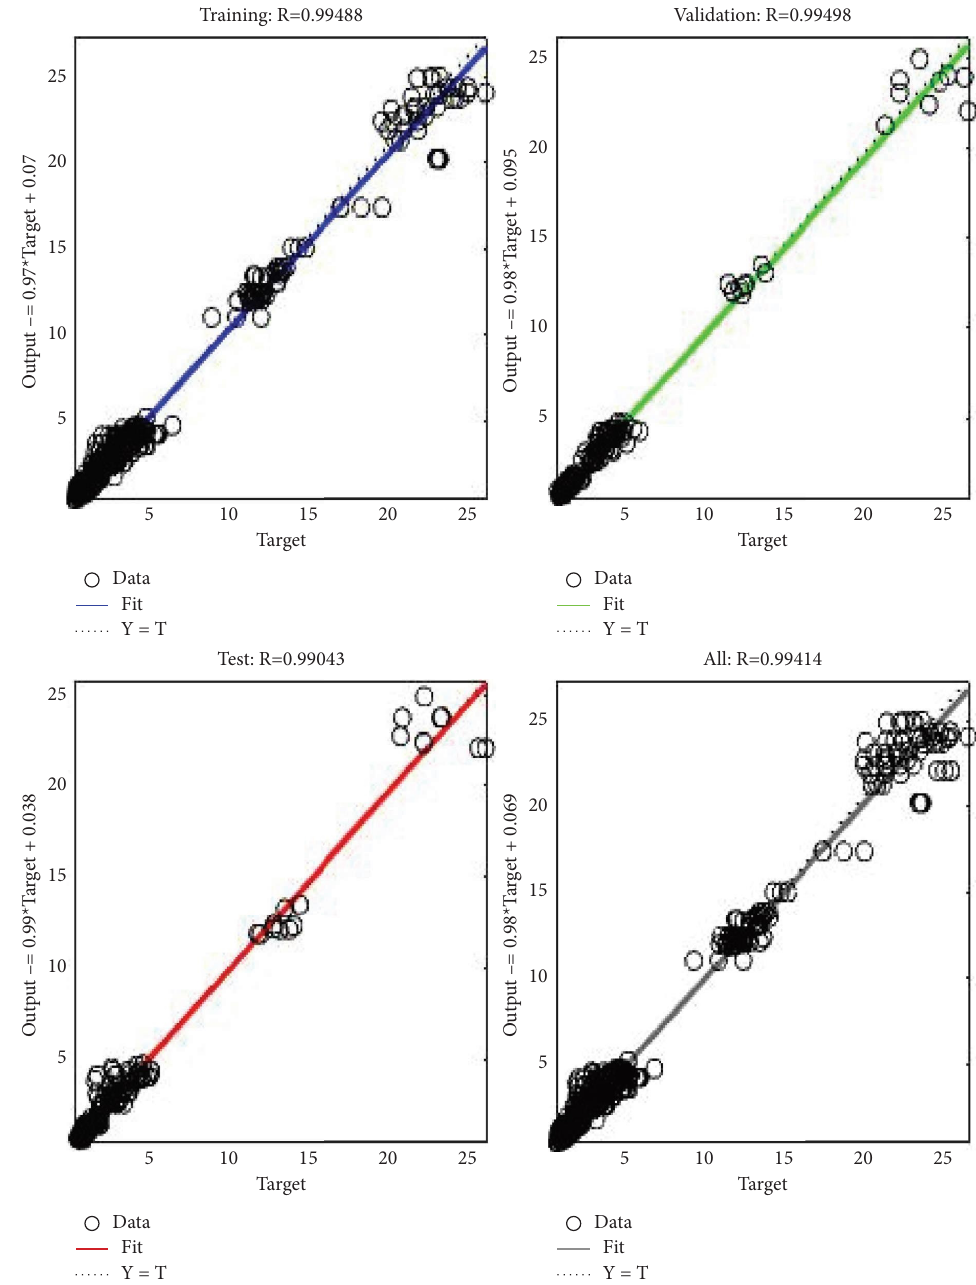
Figure 5: Results of regression between output data and targets for the LM